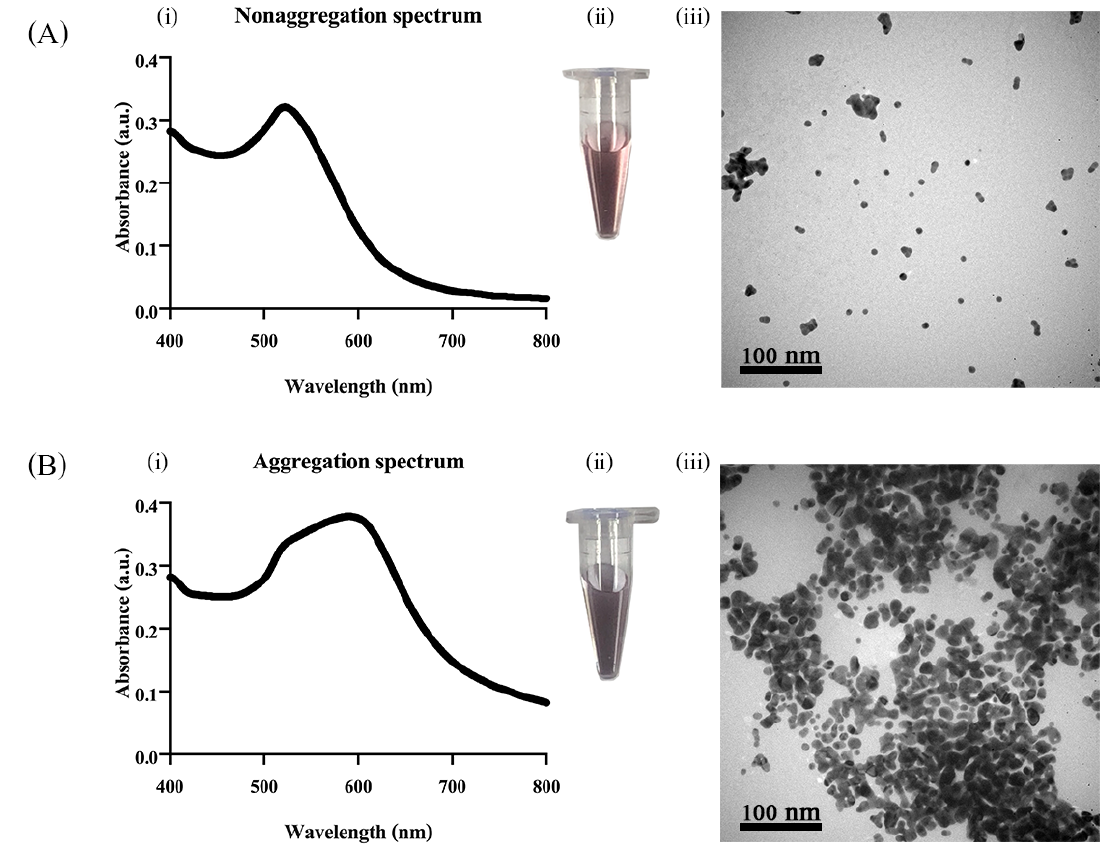
Figure 2. (i) The absorption spectra, (ii) the digital photographs and (iii) the TEM micrographs of the Thy-AuNP-AgNP solutions in the absence ( A ) and the presence ( B ) of Cu 2+ . Scale bars in the TEM micrographs are 100 nm.